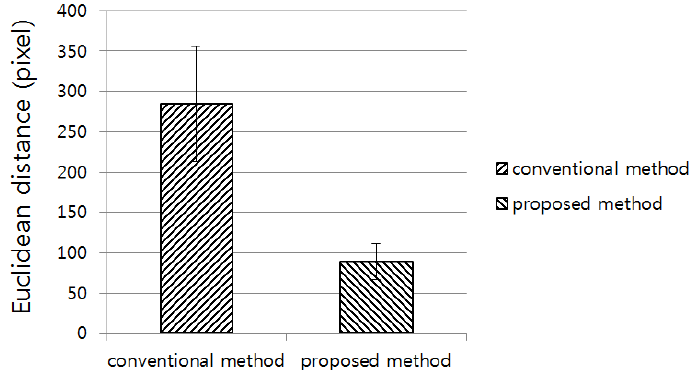
Figure 12. Comparisons of Euclidean distance between the conventional and proposed